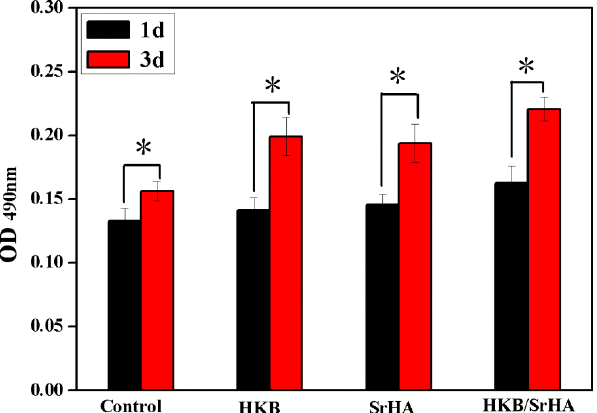
Figure 5. Proliferation of MC3T3-EI cultured in each group for 1 and 3 days. ＊ p < 0.05.